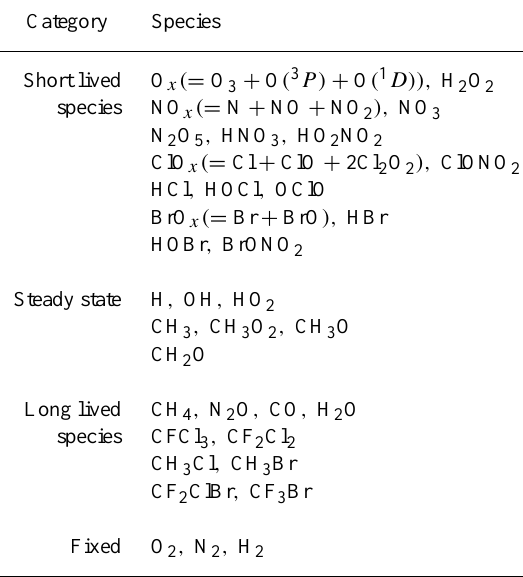
Table 2. Chemical species contained in the model Category Species